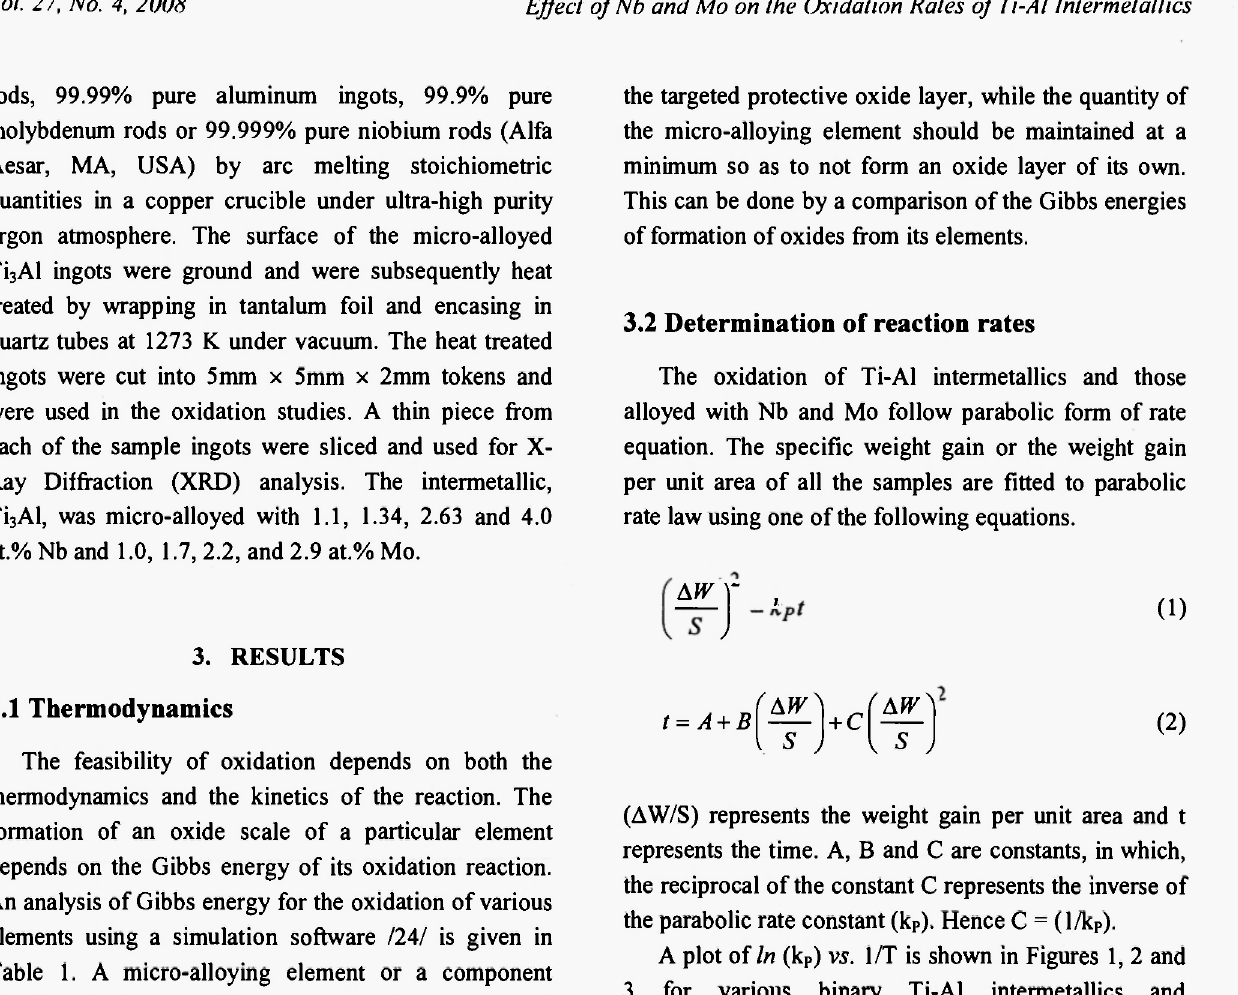
' of reaction for the oxidation of